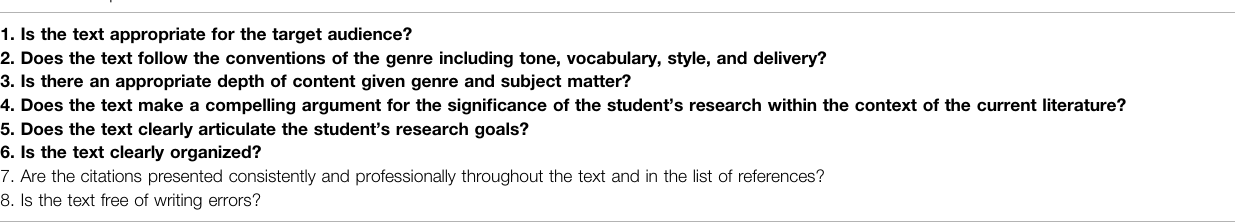
TABLE 1 | Rubric items used to assess SciWrite and non-SciWrite academic written products, arranged from “ higher-order concerns ” to “ lower-order concerns. ” Rubric itemsinboldaddresshigher-orderconcerns.Writtenproductswereassessedonascoringscalefrom1to3: “ doesnotmeetexpectations, ”“ approachesexpectations, ” and “ meets expectations.